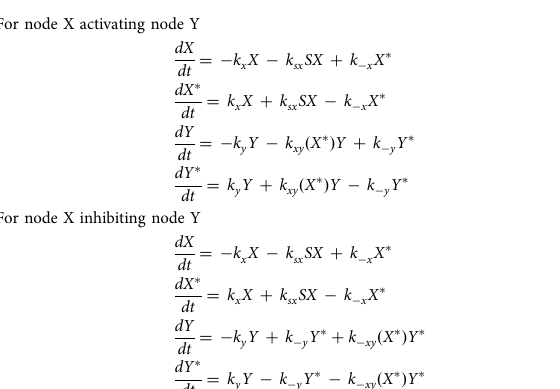
Models: Kinetics . We use models based on mass action kinetics to represent the networks. For the kinetic model of a given motif, we have one equation each for the active and inactive forms associated with each node, describing the time derivative of the concentrations of those forms. The reactions to be accounted for at each node include both interconversion reactions: inactive to active and active to inactive, each of which may be regulated by the active forms of other nodes. In addition, there may be basal rates for the same reactions (independent of other nodes). The model for the regulation of one node (labelled Y) by the other node (labelled X) is given by: